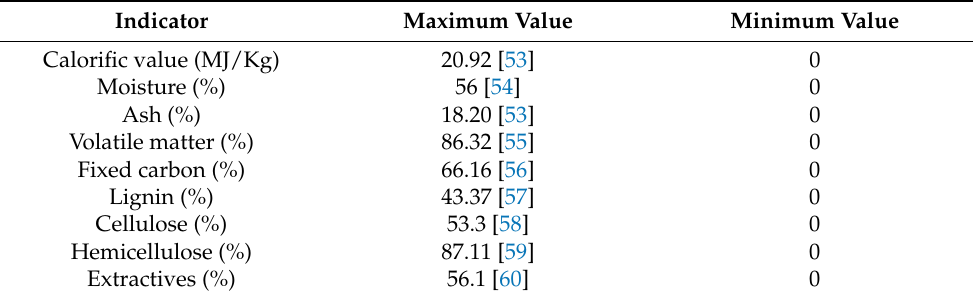
Table 5. Indicator values.